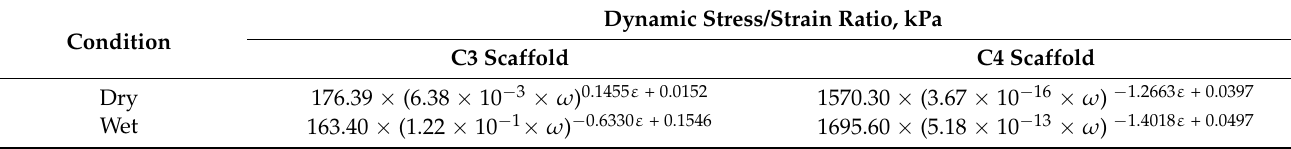
Table 2. The invariant parameters and constitutive equation for GAIN scaffolds (<50 µ m deformation).